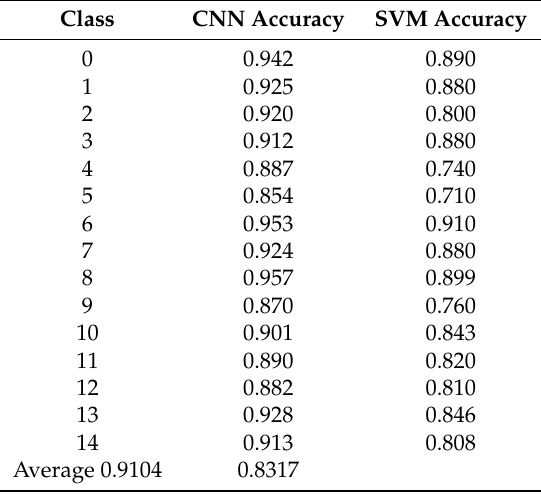
Table 1. Accuracy statistics for CNN and support vector machines